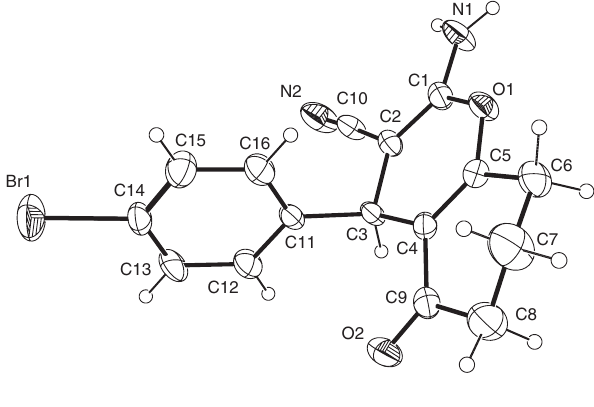
Table 2: Fractional atomic coordinates and isotropic or equivalent isotropic displacement parameters (Å 2